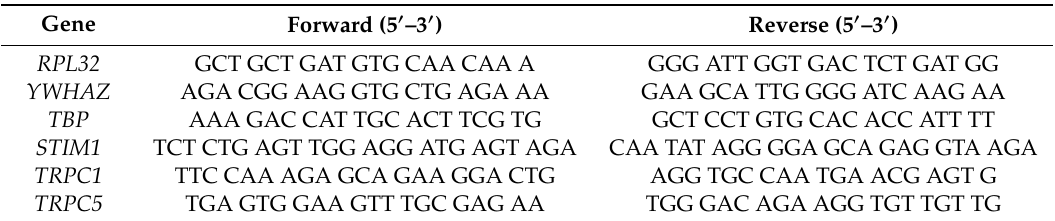
Table 2. List of primers used for